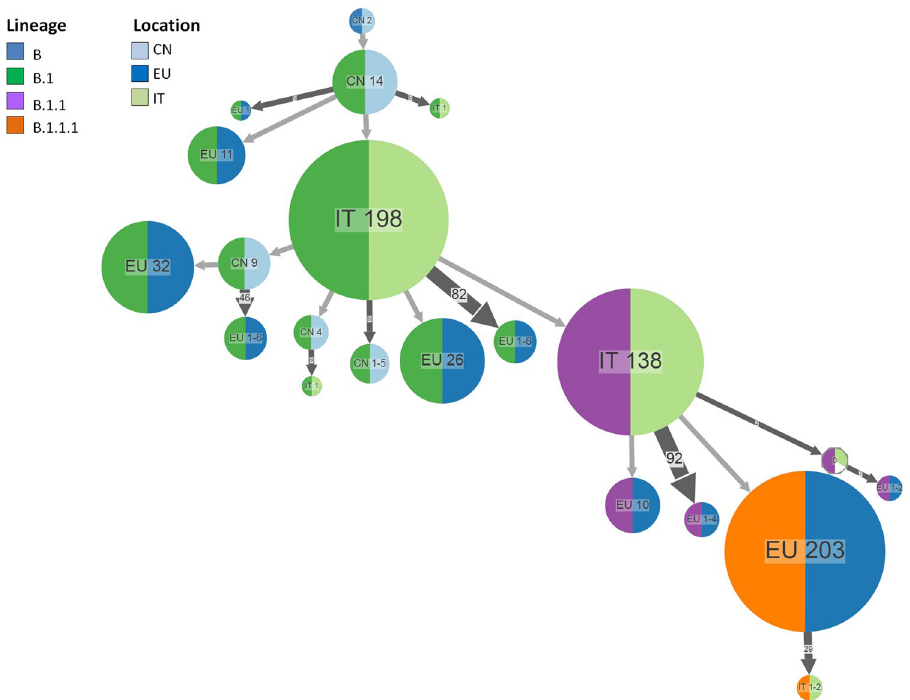
Figure 4. Ancestral reconstruction of SARS-CoV-2 lineages B.1 using the European dataset. The figure shows the compressed visualization produced by PastML using marginal posterior probability approximation (MPPA) with an F81-like model. Different colours correspond to different European countries and lineages. Numbers inside (or next to) the circles indicate the number of strains assigned to the specific node. The joint ancestral scenario (Joint) and maximum a posteriori (MAP) predictions are shown for the uncertain nodes (shown as octagonal icons). CN, China; IT, Italy, EU,